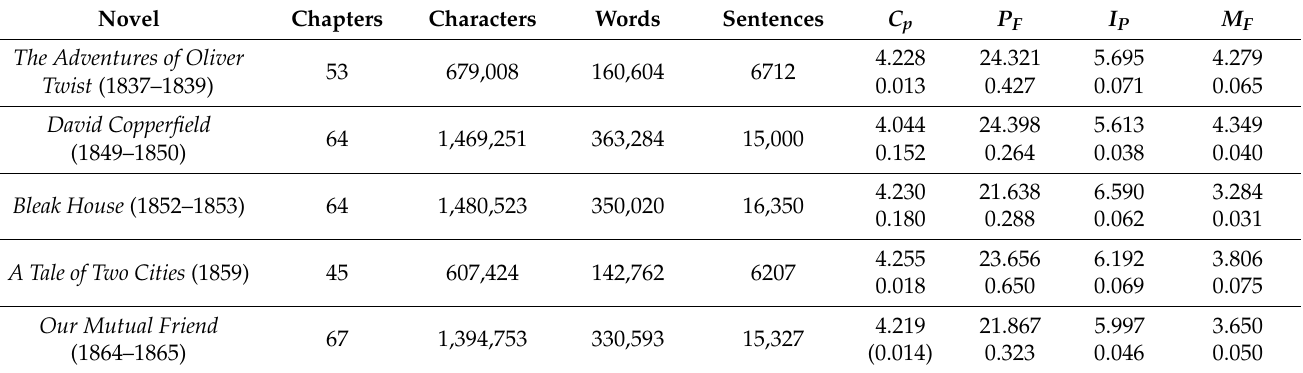
Table 1. Charles Dickens’ novels. Number of chapters (i.e., the number of samples considered in calculating the regression lines of the theory), total number of characters contained in the words, total number of words and sentences, deep language parameters C P , P F , I P , M F , with standard deviation reported in the second line.